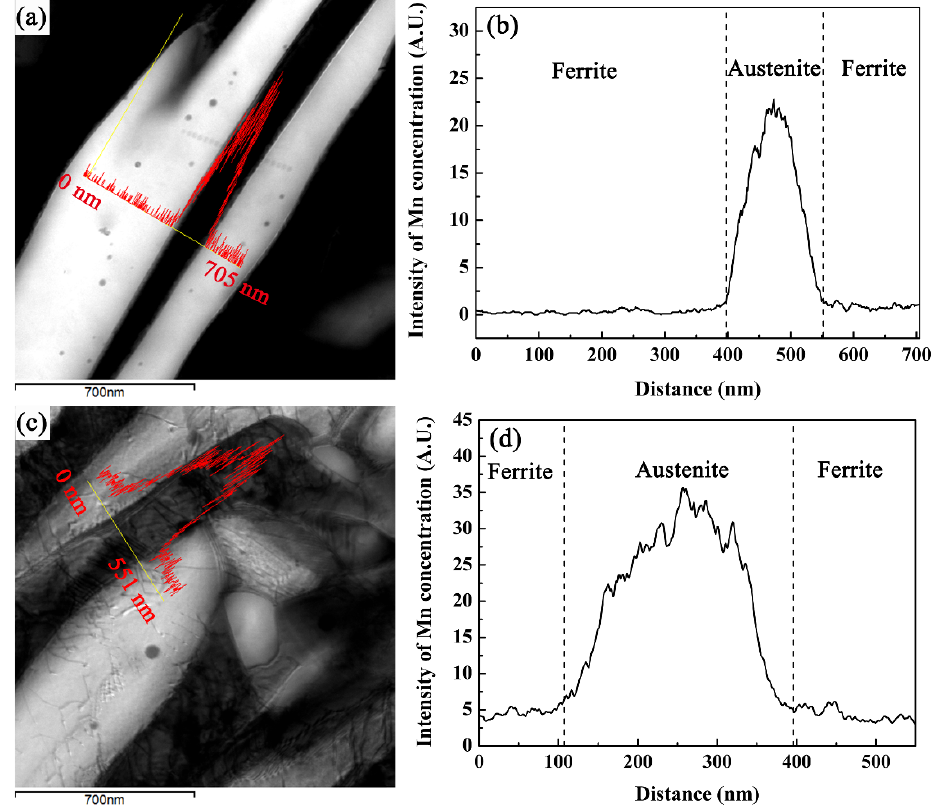
Figure 6. TEM microstructure and corresponding Mn distribution of ( a , b ) CQ2-ART and ( c , d ) CQ3- ART samples.